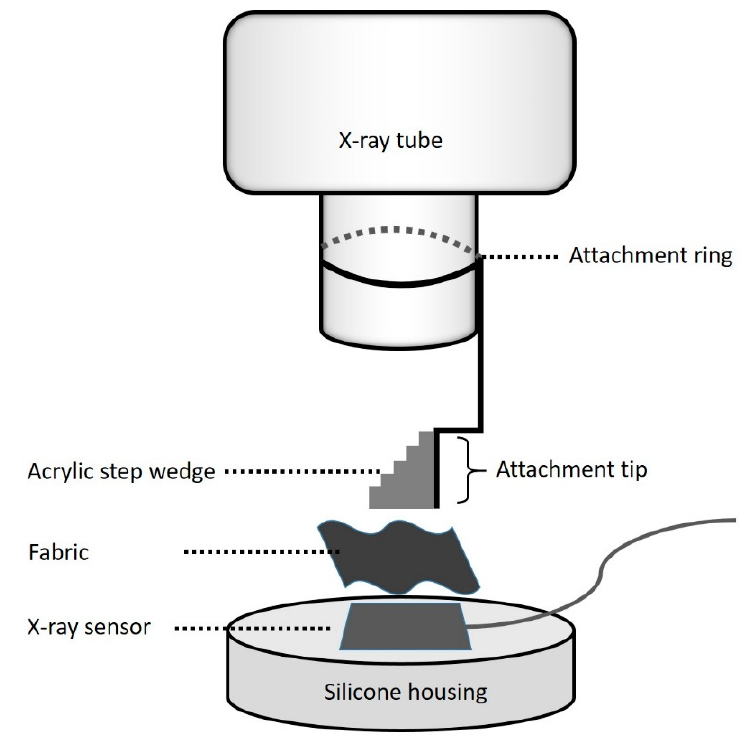
Figure 2. Schematic demonstration of the setup.